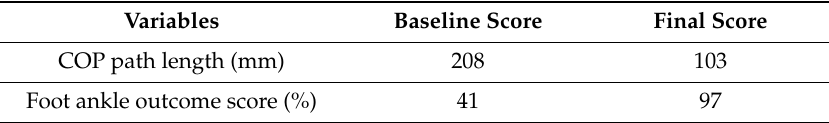
Table 3. Static balance using Zebris and foot ankle outcome